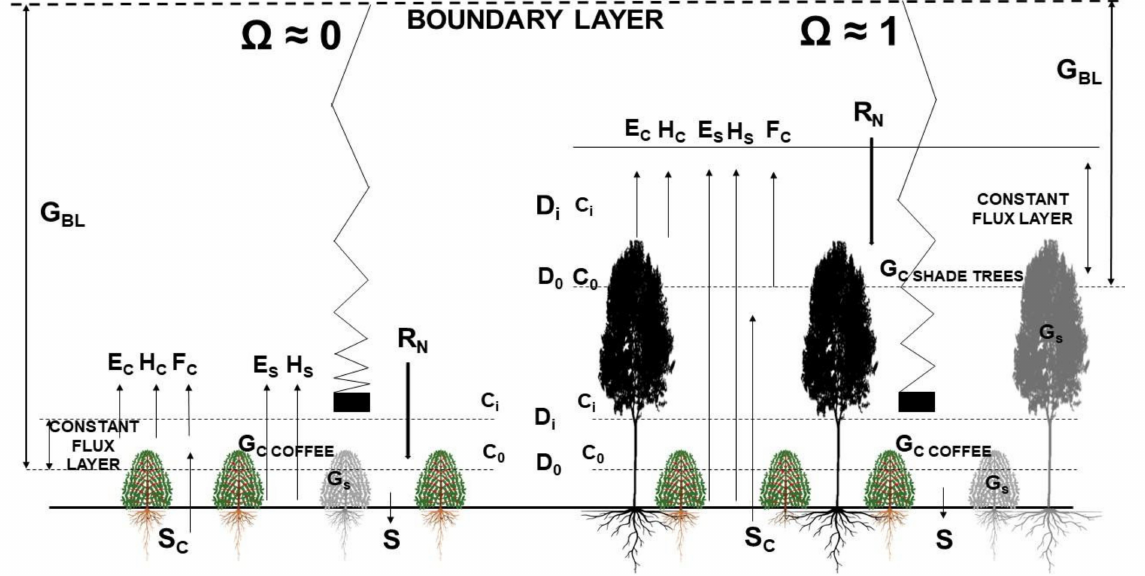
Figure 1. Schematic representation of canopy structure, driving forces, main fluxes, and conductances along the soil–plant– atmosphere continuum in a coffee monoculture exposed to full sun radiation (left side) and an agroforestry system (right side) with coffee as the main crop and several species of shade trees in Costa Rica. G C is the canopy conductance, G BL is the boundary layer conductance, D is the vapor pressure deficit of air, H is the latent heat from plant canopies and soil (H C and H S, respectively), E is the evaporation from plant canopies and soil (E C and E S, respectively), F C is the carbon assimilation by coffee shrubs and shade trees, F S is the CO 2 emissions from soil (soil respiration), S is the soil heat flux, C is the CO 2 concentration, and Ω is the omega factor. X 0 and X I denote localization of measurements at the leaf surface or within the boundary layer,